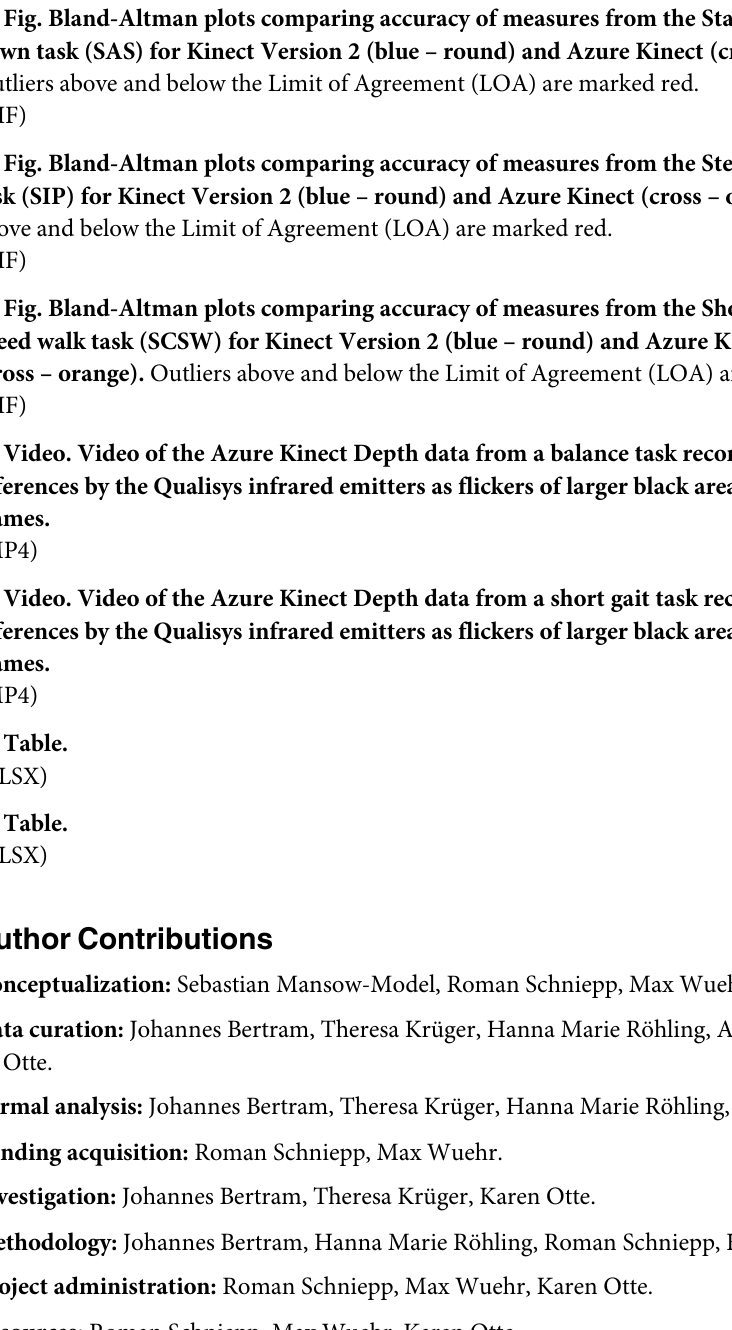
S4 Fig. Bland-Altman plots comparing accuracy of measures from the Balance task (POCO) for Kinect Version 2 (blue – round) and Azure Kinect (cross – orange). Outliers above and below the Limit of Agreement (LOA) are marked red. S5 Fig. Bland-Altman plots comparing accuracy of measures from the Stand up and sit down task (SAS) for Kinect Version 2 (blue – round) and Azure Kinect (cross – orange). Outliers above and below the Limit of Agreement (LOA) are marked red. S6 Fig. Bland-Altman plots comparing accuracy of measures from the Stepping in Place task (SIP) for Kinect Version 2 (blue – round) and Azure Kinect (cross – orange). Outliers above and below the Limit of Agreement (LOA) are marked red. S7 Fig. Bland-Altman plots comparing accuracy of measures from the Short comfortable speed walk task (SCSW) for Kinect Version 2 (blue – round) and Azure Kinect (cross – orange). Outliers above and below the Limit of Agreement (LOA) are marked red. (TIF) S1 Video. Video of the Azure Kinect Depth data from a balance task recording showing inferences by the Qualisys infrared emitters as flickers of larger black areas for some frames. S2 Video. Video of the Azure Kinect Depth data from a short gait task recording showing inferences by the Qualisys infrared emitters as flickers of larger black areas for some